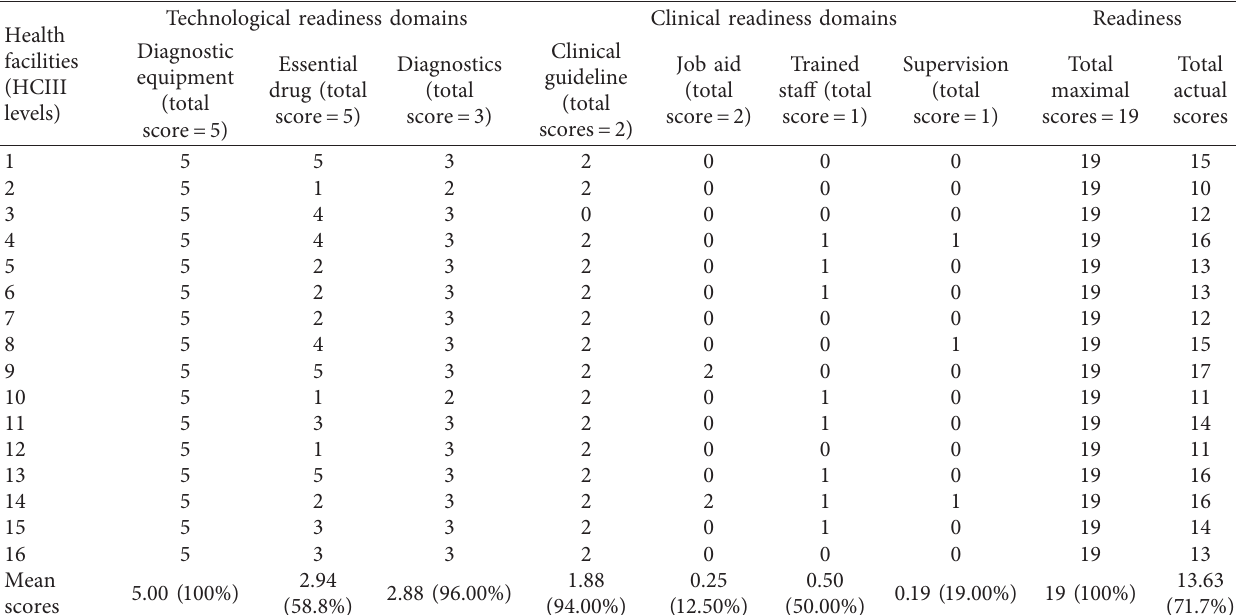
Table 3: Readiness of the health